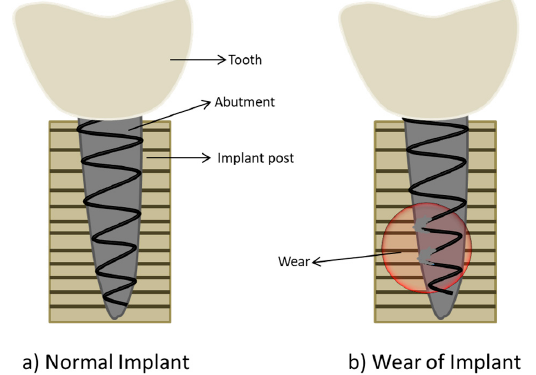
Figure 11. Representation of structural loss of dental implant due to wear. ( a ) represents the normal implant after insertion, and ( b ) represents the wear of